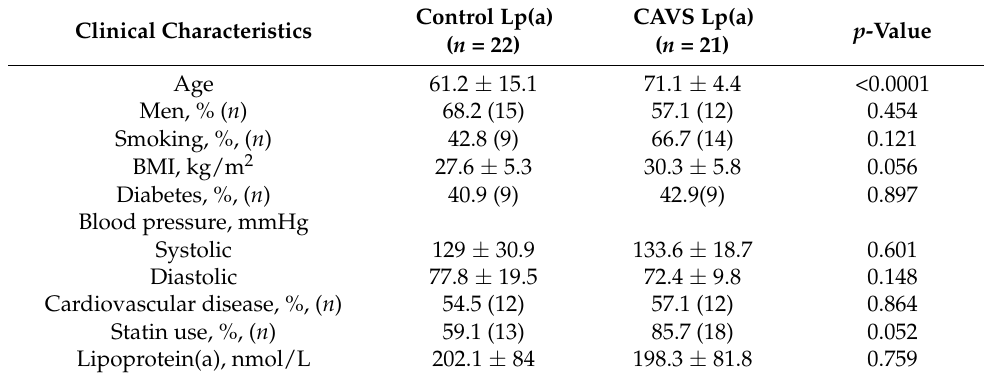
Table 1. Patient characteristics for Lp(a)-isolated particles.